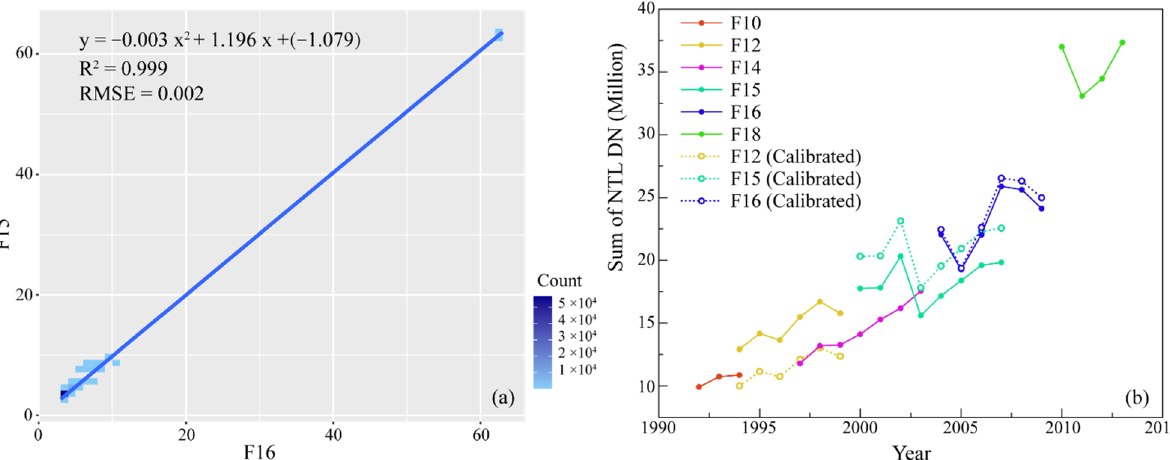
Figure 5. ( a ) The fitting parameters of the F16 hybrid calibration model and ( b ) the variation trend of the total DN value of calibrated lit pixels.